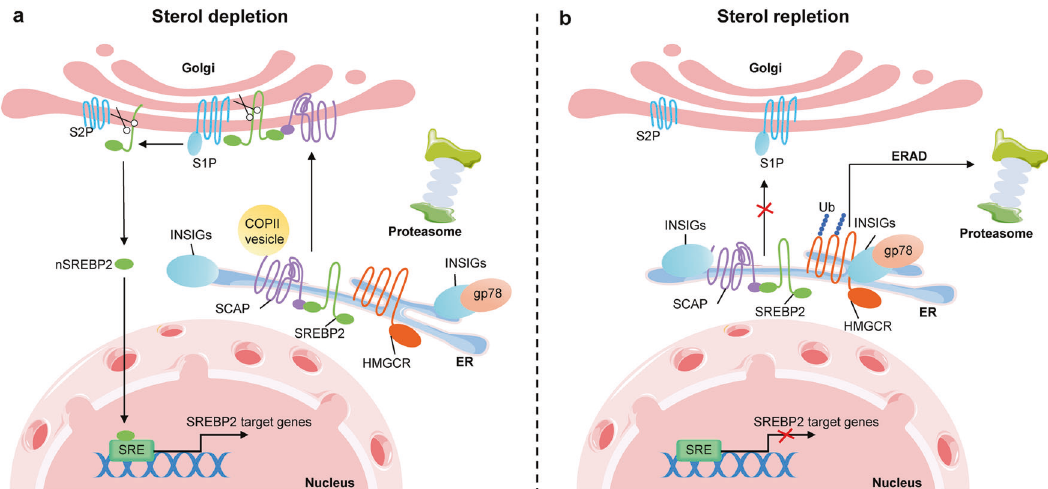
Fig. 2 SREBP2 pathway in regulation of cholesterol biosynthesis. The process of cholesterol biosynthesis is strictly regulated by negative feedback, of which the sterol regulatory element binding protein (SREBP) pathway and the HMG-CoA reductase (HMGCR) degradation pathway are the two main mechanisms of negative feedback regulation. a SREBP2 forms a complex with SREBP cleavage activating protein (SCAP) at the ER. When sterol depletion occurs to cells, SCAP binds to COPII vesicles, allowing the SCAP-SREBP complex to translocate from the ER to the Golgi for cleavage. SREBP2 is sequentially cleaved by S1P and S2P in the Golgi, and the N-terminal of SREBP2 is subsequently transported to the nucleus, where the N-terminal of SREBP2 recognizes and binds to the SRE sequence on the target gene promoter to activate the target gene transcription. In addition, HMGCR is also prevented from binding to INSIGs and gp78 (ubiquitin ligase) during cholesterol depletion, thereby stabilizing HMGCR to activate cholesterol biosynthesis. b When the cell sterol is replete, it triggers the interaction of SCAP with INSIGs, resulting in blocking the binding of SCAP to COPII and keeping the SCAP-SREBP2 complex in the ER. At the same time, HMGCR also binds to INSIGs and gp78, which catalyzes the ubiquitination of HMGCR. The ubiquitinated HMGCR is eventually degraded in the proteasome via ER-related degradation (ERAD). Ub